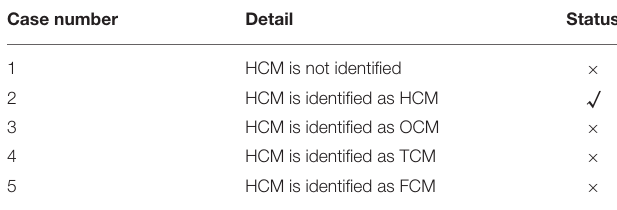
TABLE 3 | Five cases for HCM identification.